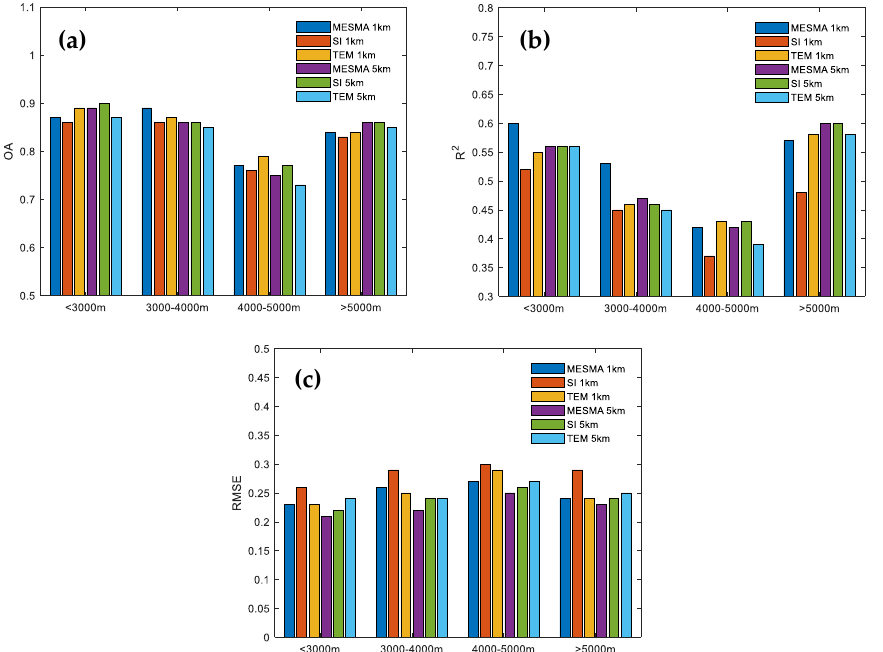
Figure 7. Accuracy evaluation results at different altitudes for three AVHRR/2 fractional snow cover retrieval algorithms at 1 km and 5 km scales based on 313 Landsat–5/TM scenes: ( a ) the OA of the three AVHRR/2 FSC retrieval algorithms at 1 km and 5 km scales; ( b ) the R 2 of the three AVHRR/2 FSC retrieval algorithms at 1 km and 5 km scales; ( c ) the RMSE of the three AVHRR/2 FSC retrieval algorithms at 1 km and 5 km scales.